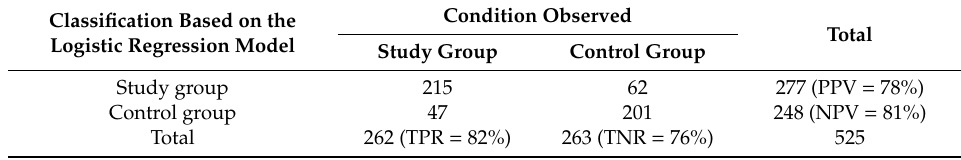
Table 9. Results of the classification of the patients in the studied